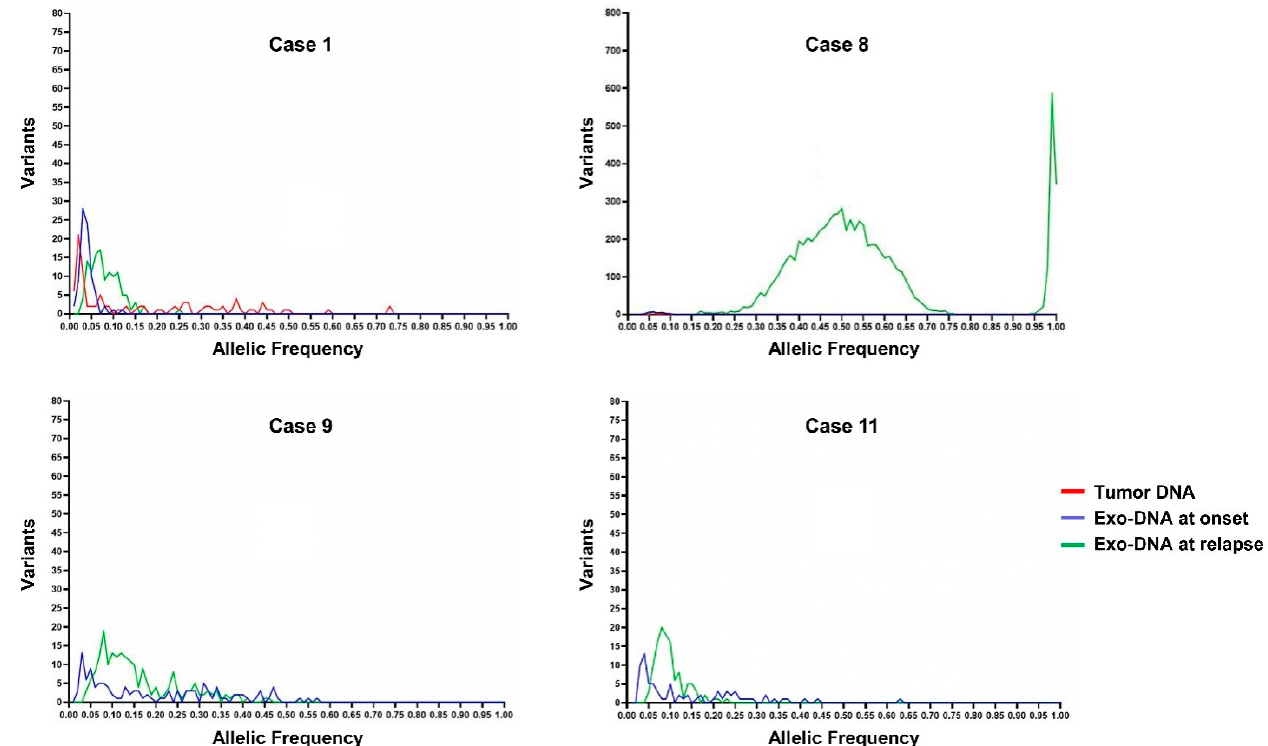
Figure 5. Somatic SNVs frequency in NB cases with exo-DNA at relapse.